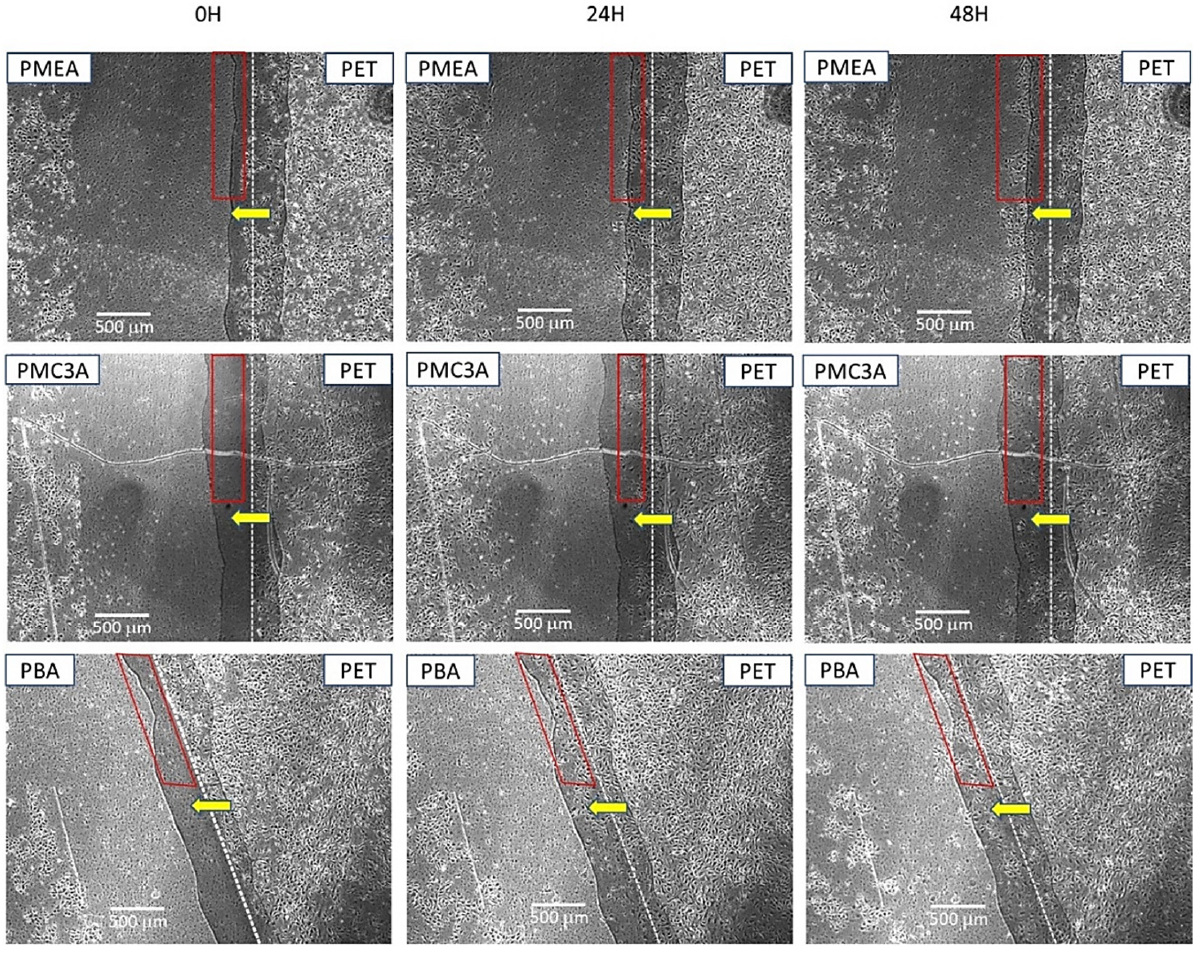
Figure 7. Observation of HUVECs migration between the substrate surfaces (scale bar = 500 μ m). Time laps imaging confirmed the HUVECs migration from PET to polymers through the interface of PMEA-PET, PMC3A-PET, and PBA-PET. Migration was recorded from 0 to 48 h. The migration processes are marked with red rectangles and yellow arrows.